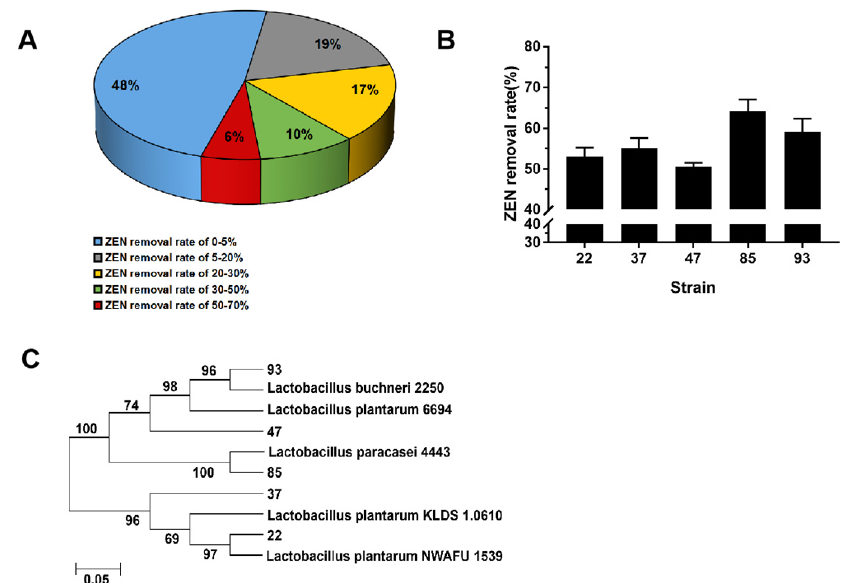
Figure 1. Strain screening for a high ZEN removal ability. ( A ) Distribution characteristics of the LAB derived from pickles (87 strains in total) according to the ZEN removal rate; ( B ) ZEN removal rate of the top 5 strains; ( C ) Phylogenetic relationship of the top 5 strains constructed by 16S rDNA sequences from evolutionary distances. Table 1. Carbohydrate reactions of the top 5 LAB strains with high ZEN removal ability.